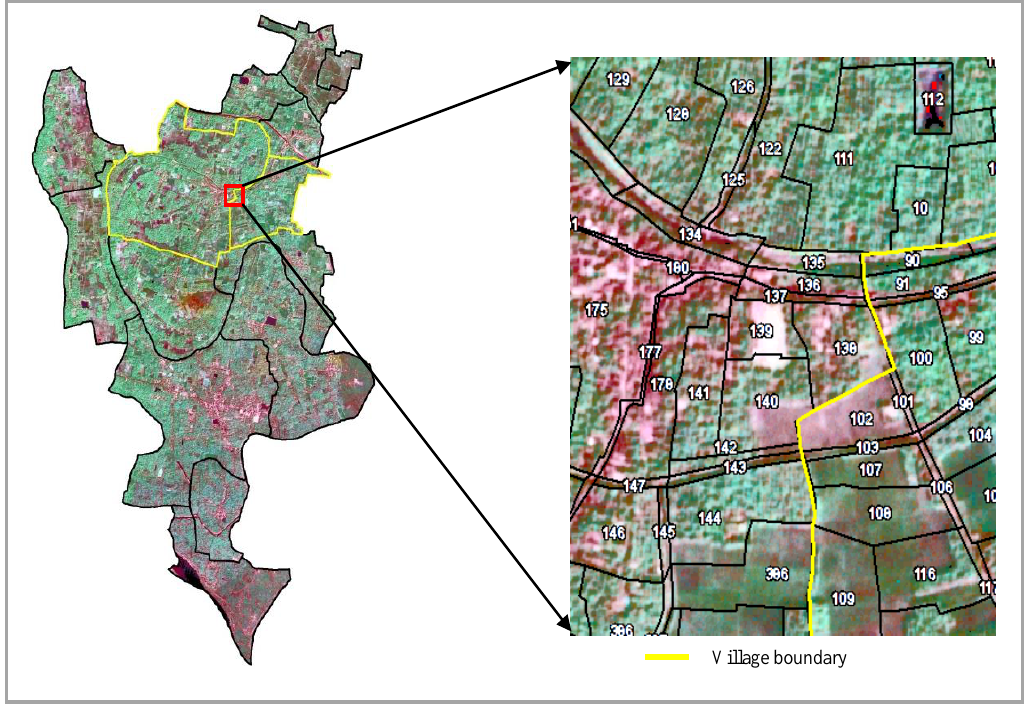
Figure 10: Village boundary (derived from cadastral map) overlaid on HRSI 3.1.2. Comparison between Village boundary (2011) and Village boundary (derived from cadastral maps) The village boundary (2011) overlaid on HRSI is shown in through the mid of the land parcel dividing it into two parts the Figure 11. The village boundary is intersecting the village with each part assigned to different village polygon. Ideally a cluster assigning the same village cluster to two different single land parcel or a village cluster should be mapped to a village polygons. Further the village boundary is passing single village polygon.